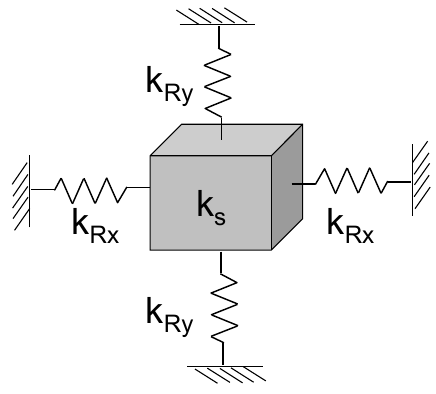
Figure 2. Solid-spring model.